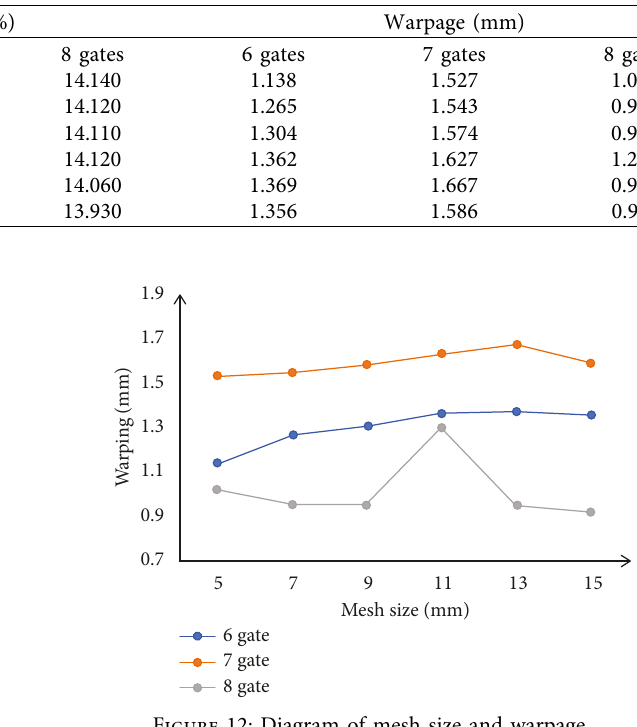
Table 3: Statistical table of volume shrinkage and warpage analysis results of different mesh sizes.